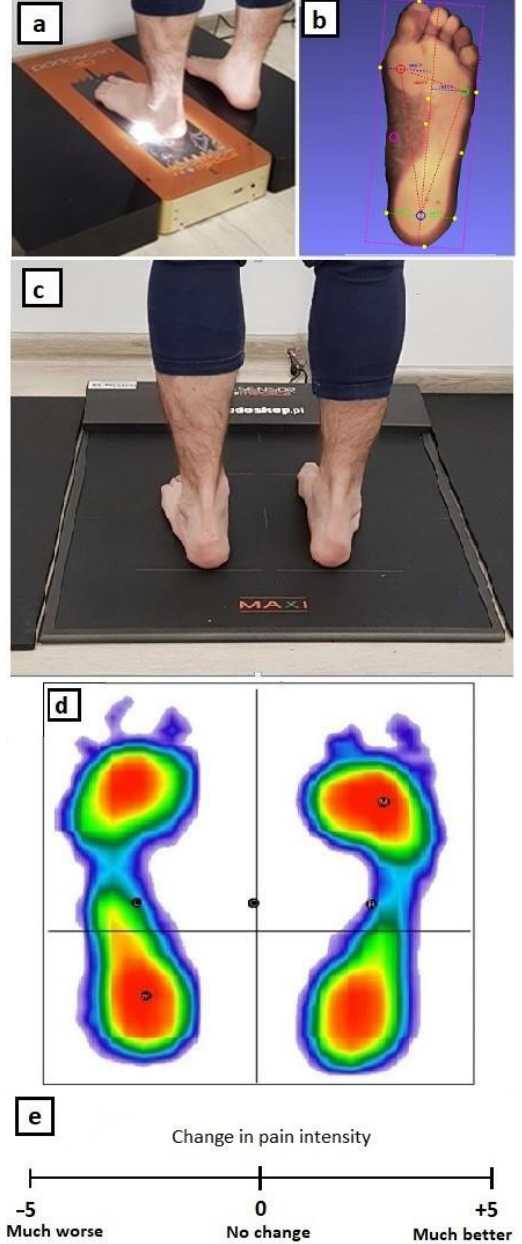
Figure 1. Performing a 3D scan of the left foot ( a ) and an example result ( b ), performing a static baropodometric test ( c ) and an example result ( d ), linear scales of subjective feelings regarding a change in functionality and pain symptoms of the foot where the distance (mm) from the “0” point with the appropriate sign constituted the numerical response of the patient ( e ).